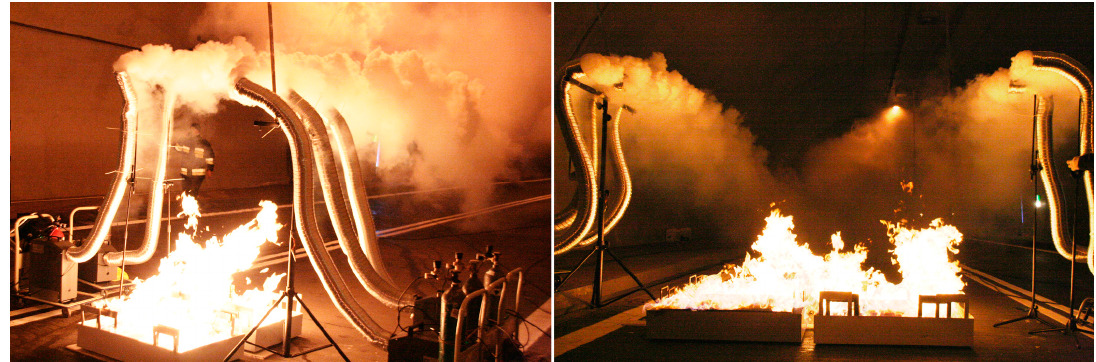
Figure 3. Configuration of the generators and trays during both hot smoke tests (left—two trays, right—four trays).